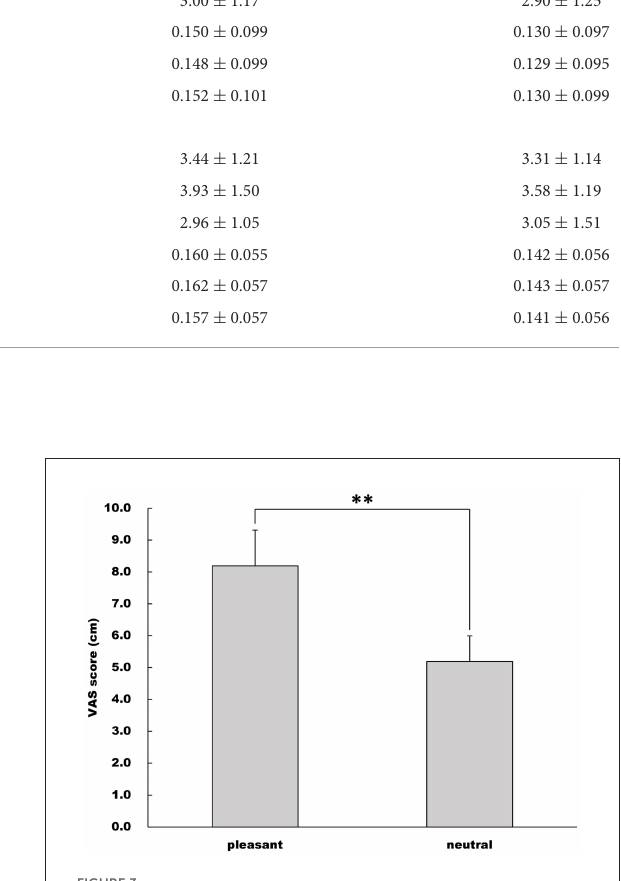
FIGURE3 Rate of emotional valence. Emotional valence was quantified using the VAS score (cm). This figure shows the mean and standard deviation of VAS scores in the pleasant and neutral image conditions. ** p < 0.01.